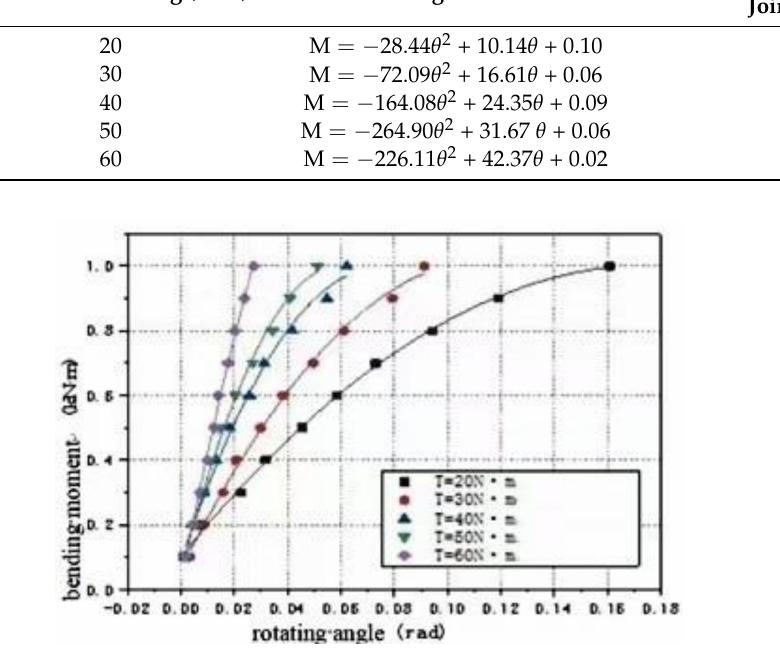
Figure 3. Bending moment–rotation angle curve of nodes under different torsional moments.